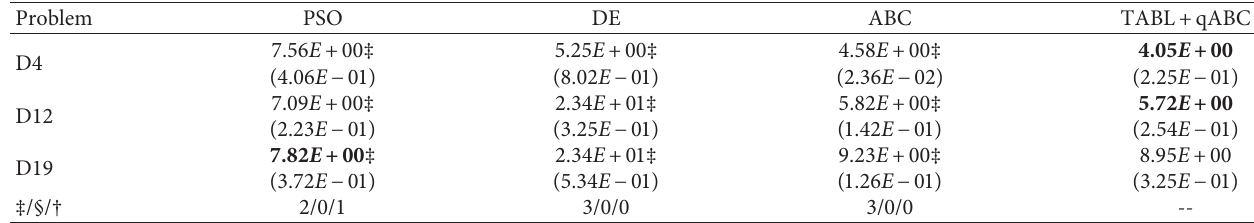
Table 11: Experimental results of four